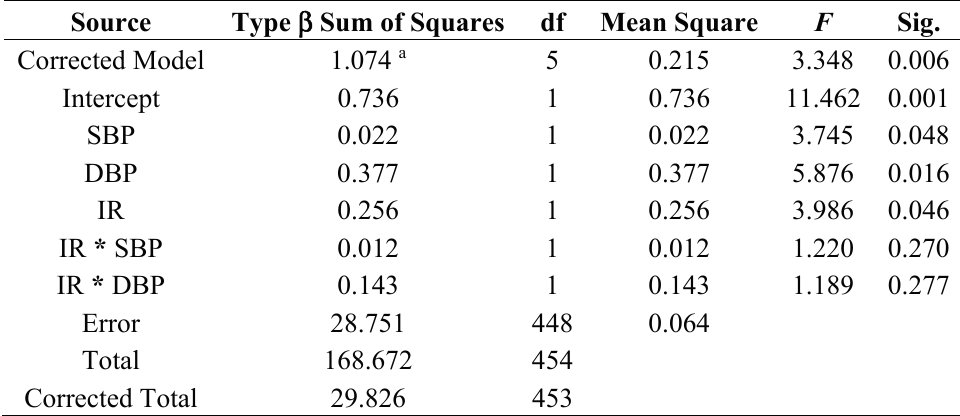
Table 4. Interaction analysis by analysis of covariance.